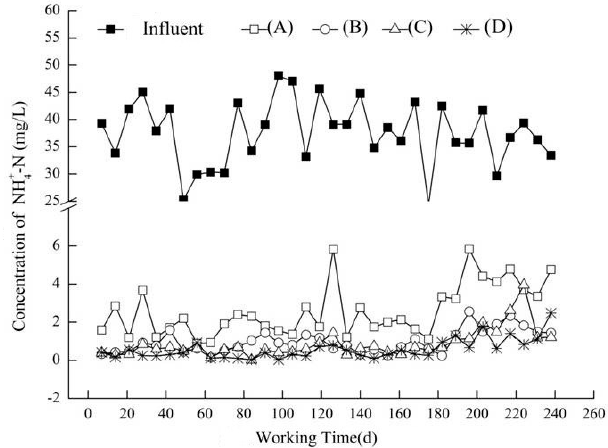
Figure 3. Removal rate of NH 4+ -N in the four different devices (A–D). Table 3. Removal efficiency of nutrients in the different TF-CW simulators.